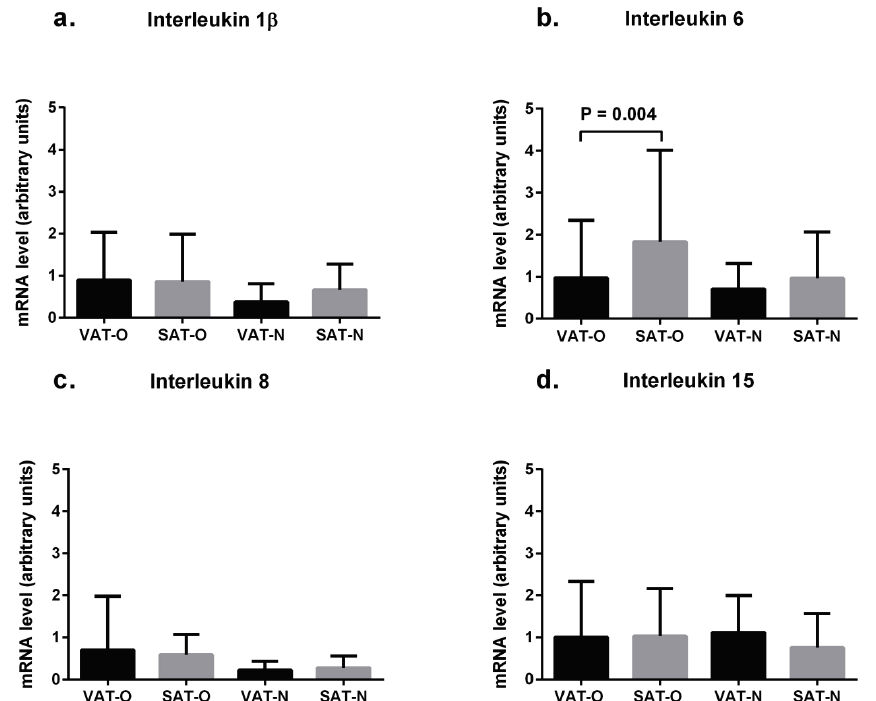
Figure 2. Mean interleukin 1 β ( a ), interleukin 6 ( b ) interleukin 8 ( c ) and interleukin 15 ( d ) mRNA levels in the visceral (VAT) and subcutaneous (SAT) adipose tissues of obese (O) and normal-weight (N) individuals. Results, normalized against the expression of ACTB , are shown as mean ± standard